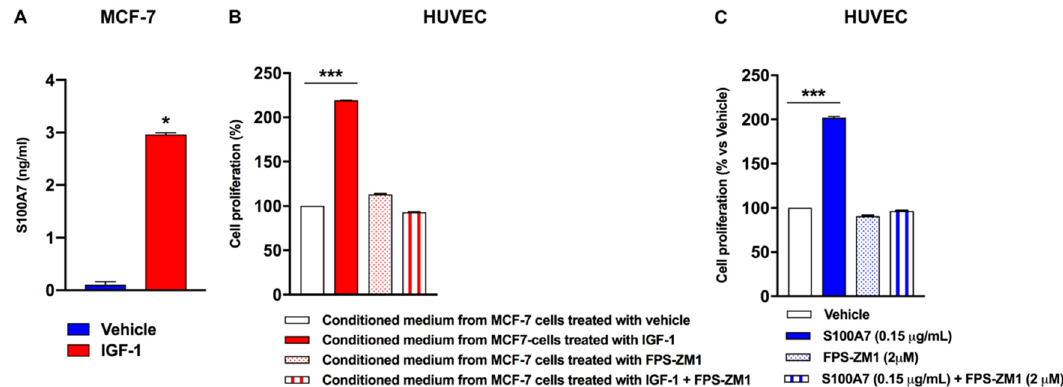
Figure 6. Paracrine release of S100A7 by BC cells induces proliferative effects in HUVECs. ( A ) Evaluation of S100A7 concentration in conditioned medium from MCF-7 cells treated with vehicle or IGF-1 (10 nM, 48 h), as evaluated by ELISA. Data shown are the mean ± SEM of at least three independent experiments performed in duplicate. ( B ) HUVECs were cultured in medium collected from MCF-7 cells treated with either vehicle or IGF-1 (10 nM, 48 h), in the presence of the RAGE inhibitor FPS-ZM1 (2 μ M). Thereafter, HUVECs were subjected to SRB assay for the evaluation of cell growth. ( C ) HUVECs were cultured in 0.1% FBS in the presence of vehicle and human recombinant S100A7 (0.15 μ g/mL), alone and in combination with the RAGE inhibitor FPS-ZM1 (2 μ M), as indicated. After 48 h, HUVECs were subjected to SRB assay for the evaluation of cell growth. Data shown are the mean ± SEM of at least 2 independent experiments performed in sextuplicate. (*) p < 0.05; (***) p < 0.001.